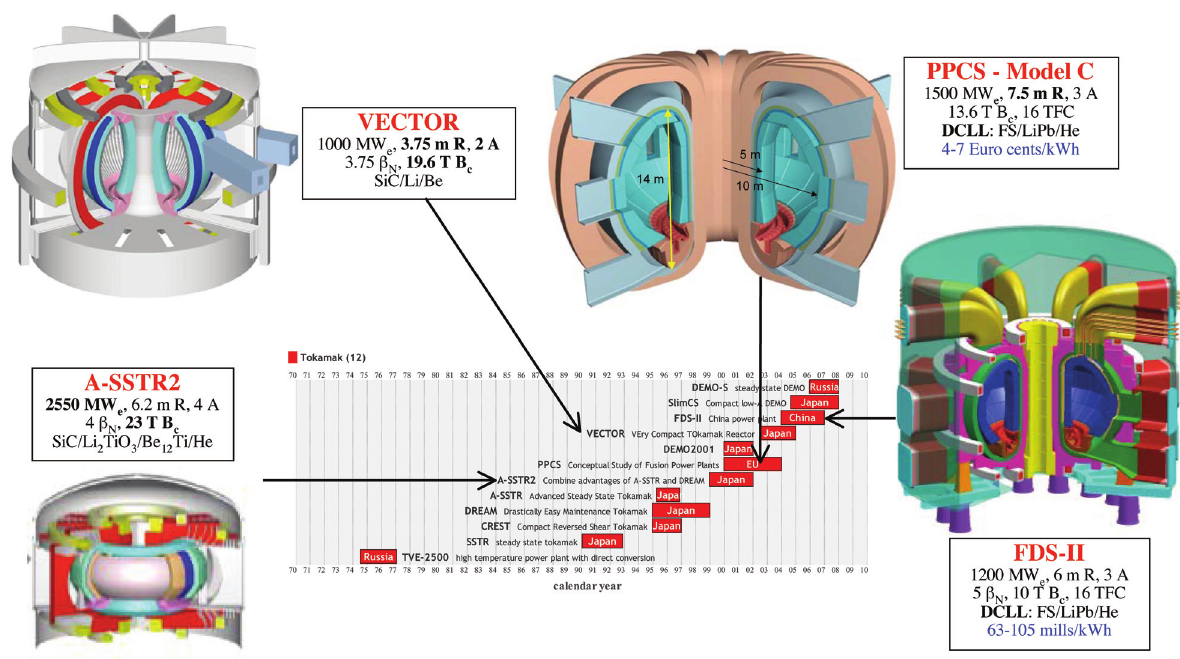
Figure 3. Timeline and main features of non-US tokamak power plant